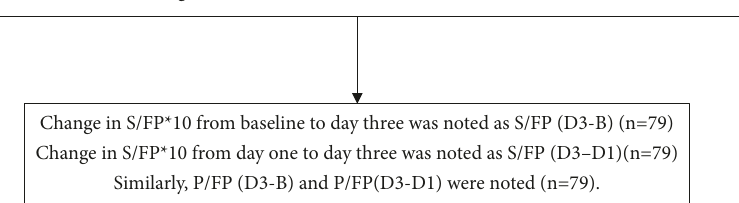
Figure 1: Flowchart depicting the methodology of the